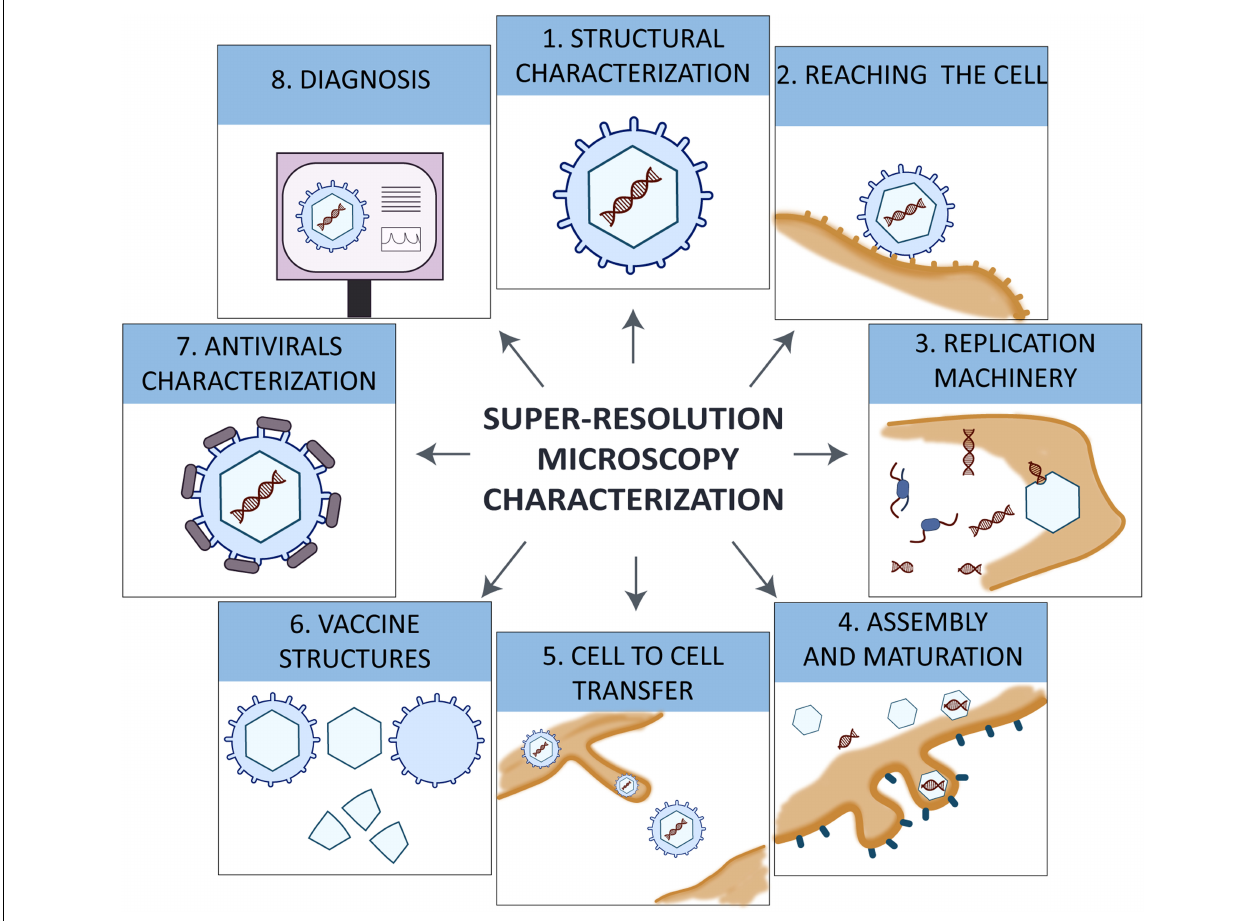
FIGURE 1 | Diagram of all viral steps studied with super-resolution microscopy STED, SIM, and